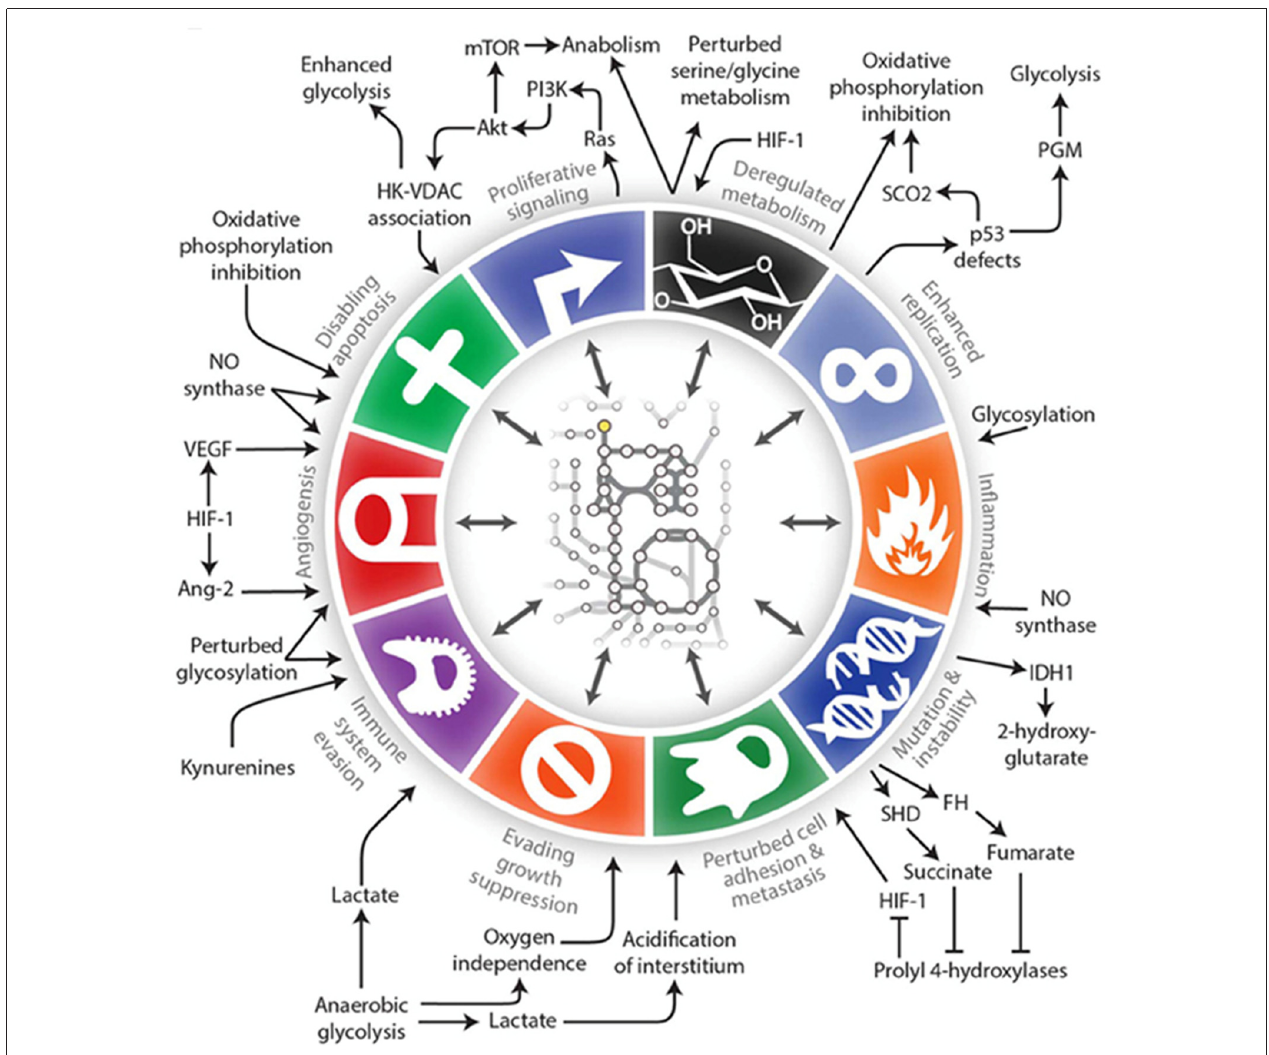
FIGURE 1 | An illustration of the interconnections between tumor metabolism with Hanahan and Weinberg’s Hallmarks of Cancer (Lewis and Abdel-Haleem,